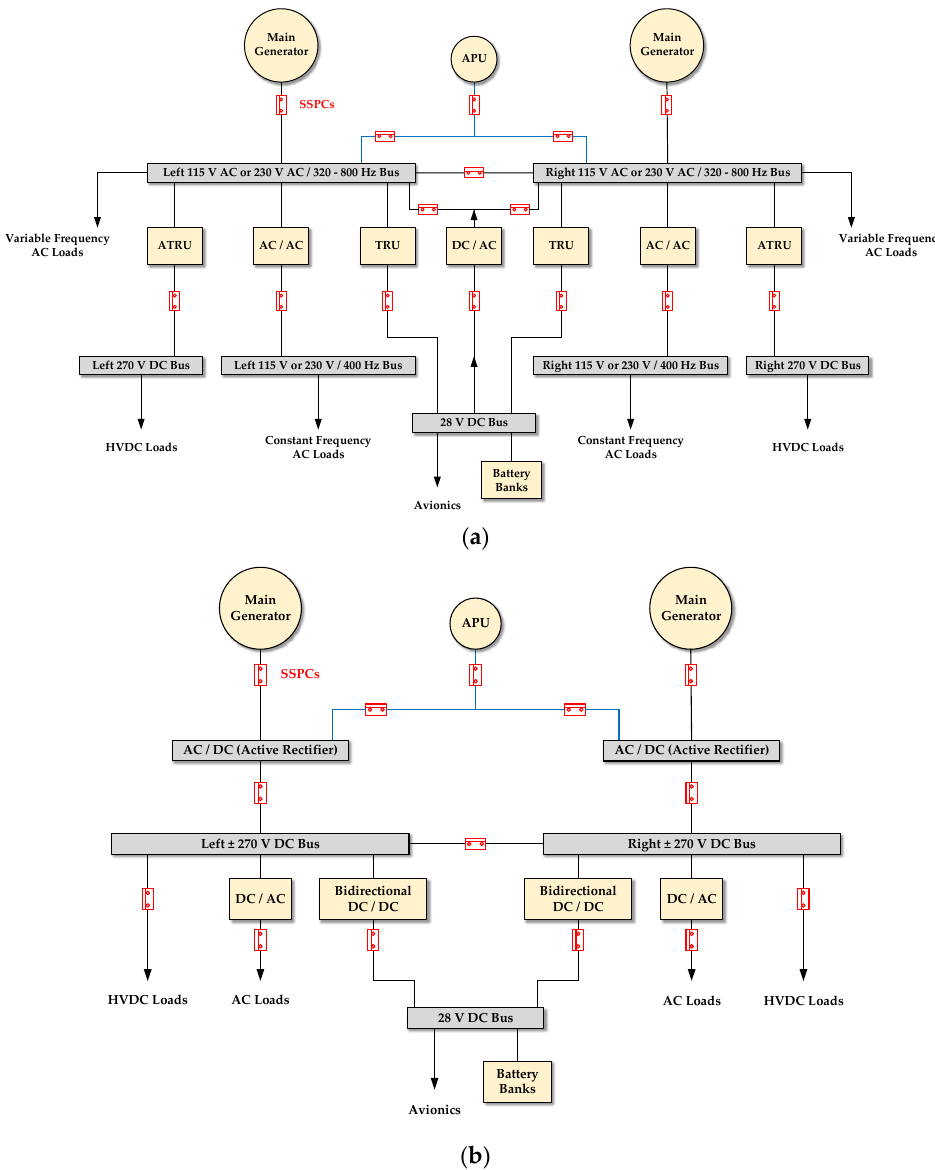
Figure 2. Proposed distribution network architectures for future aircrafts; ( a ) hybrid AC and DC configuration, which is used in Airbus 380 and Boeing 787 and ( b ) purely HVDC configuration, which is proposed within the framework of Clean Sky JU [10] and MOET EU [11].